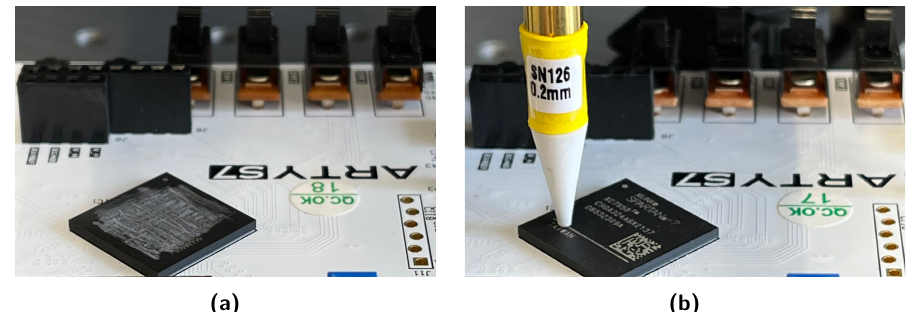
Figure 8: Devices under attack (a) Polished FPGA package (b) Placing an EM probe on top of the FPGA package.